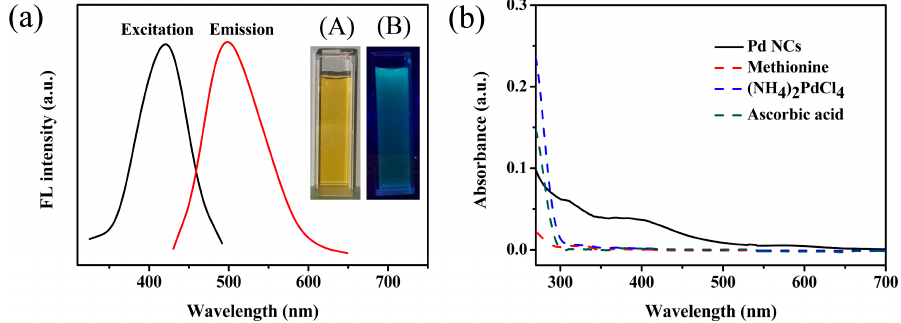
Figure 2. ( a ) Fluorescence excitation and emission spectra of the as-synthesized Pd NCs. Inset shows photographs of the Pd NCs aqueous solution in room light (A) and UV light (B); ( b ) UV-vis absorption spectra of the Pd NCs, methionine, (NH 4 ) 2 PdCl 4 and ascorbic acid.